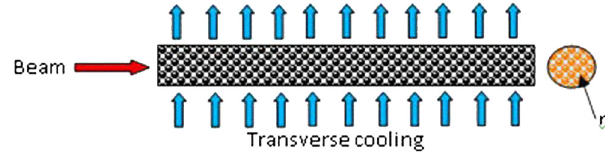
FIG. 16. Packed bed ideal flow configuration.